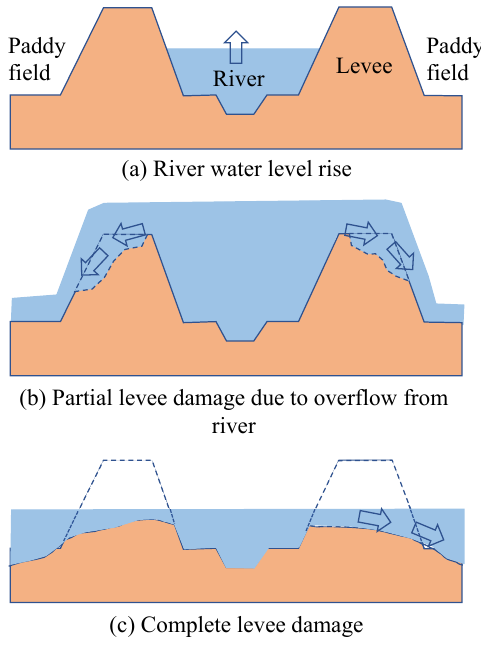
Figure 18. Breaching mechanism of the upstream levee location: ( a ) River water level rise, ( b ) Partial levee damage due to overflow from river, ( c ) Complete levee damage.